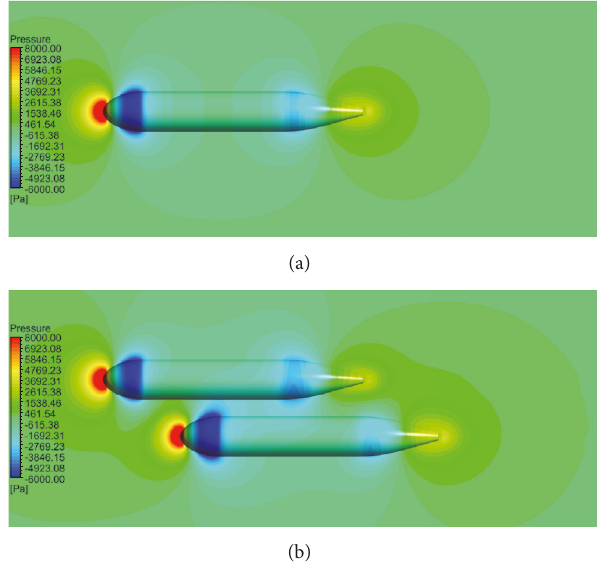
Figure 17: Pressure distributions along the longitudinal direction of the AUV: (a) single AUV and (b) optimal AUV fleet.